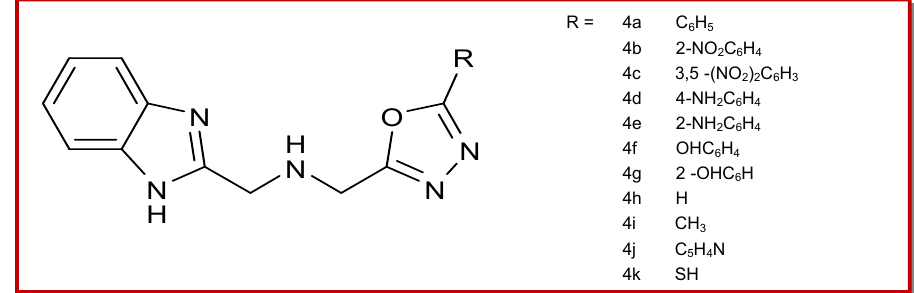
Figure 1: Synthesized 1,3,4-oxadiazole derivative from benzimidazole 4a-4k